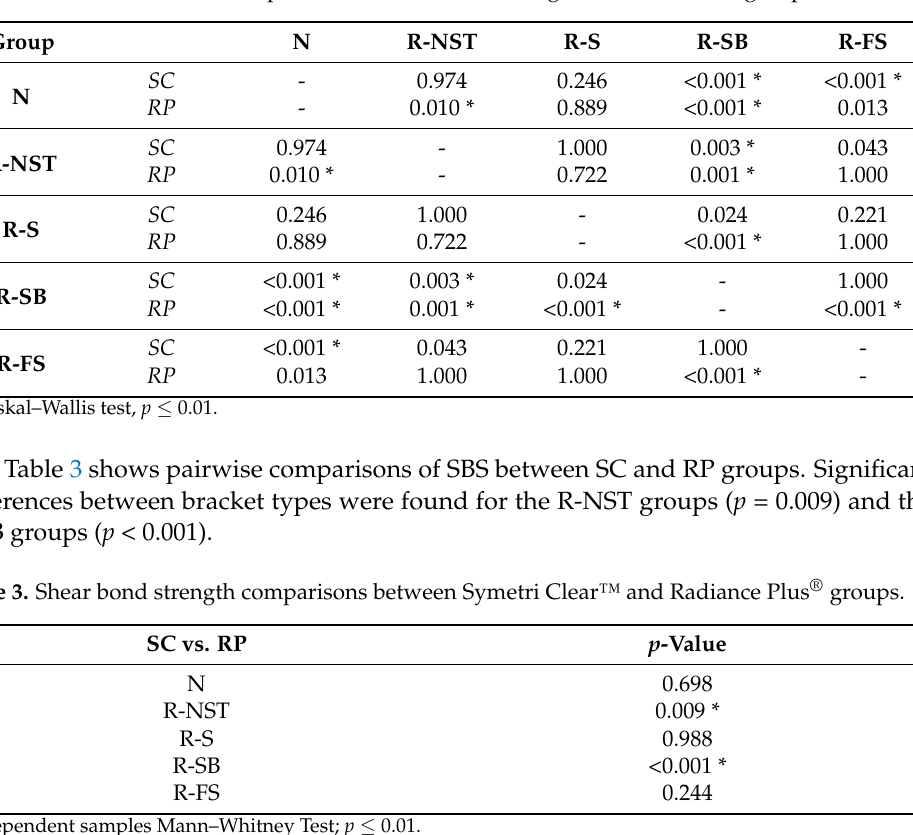
Table 2. Pairwise statistical comparisons of shear bond strengths within bracket groups.